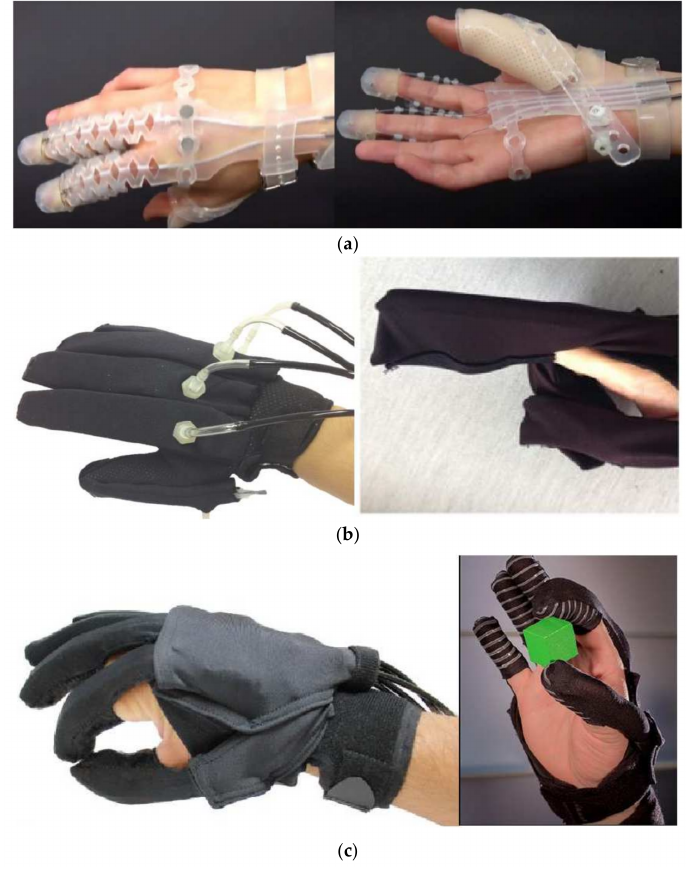
Figure 5. ( a ) Close-up view of the Exo-Glove Poly; ( b ) Close-up view of the flexible rehabilitation glove designed by the National University of Singapore; ( c ) Close-up view of the Compliant Hand Based on a Novel Pneumatic Actuator designed by Harvard University [38–45].